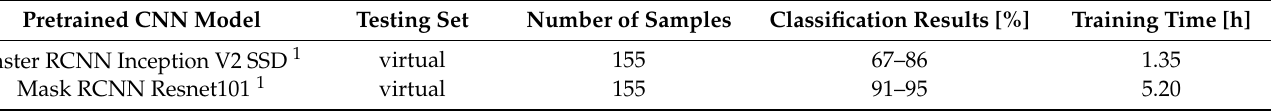
Table 1. The acquired results by autogenerated training samples based on virtual 3D